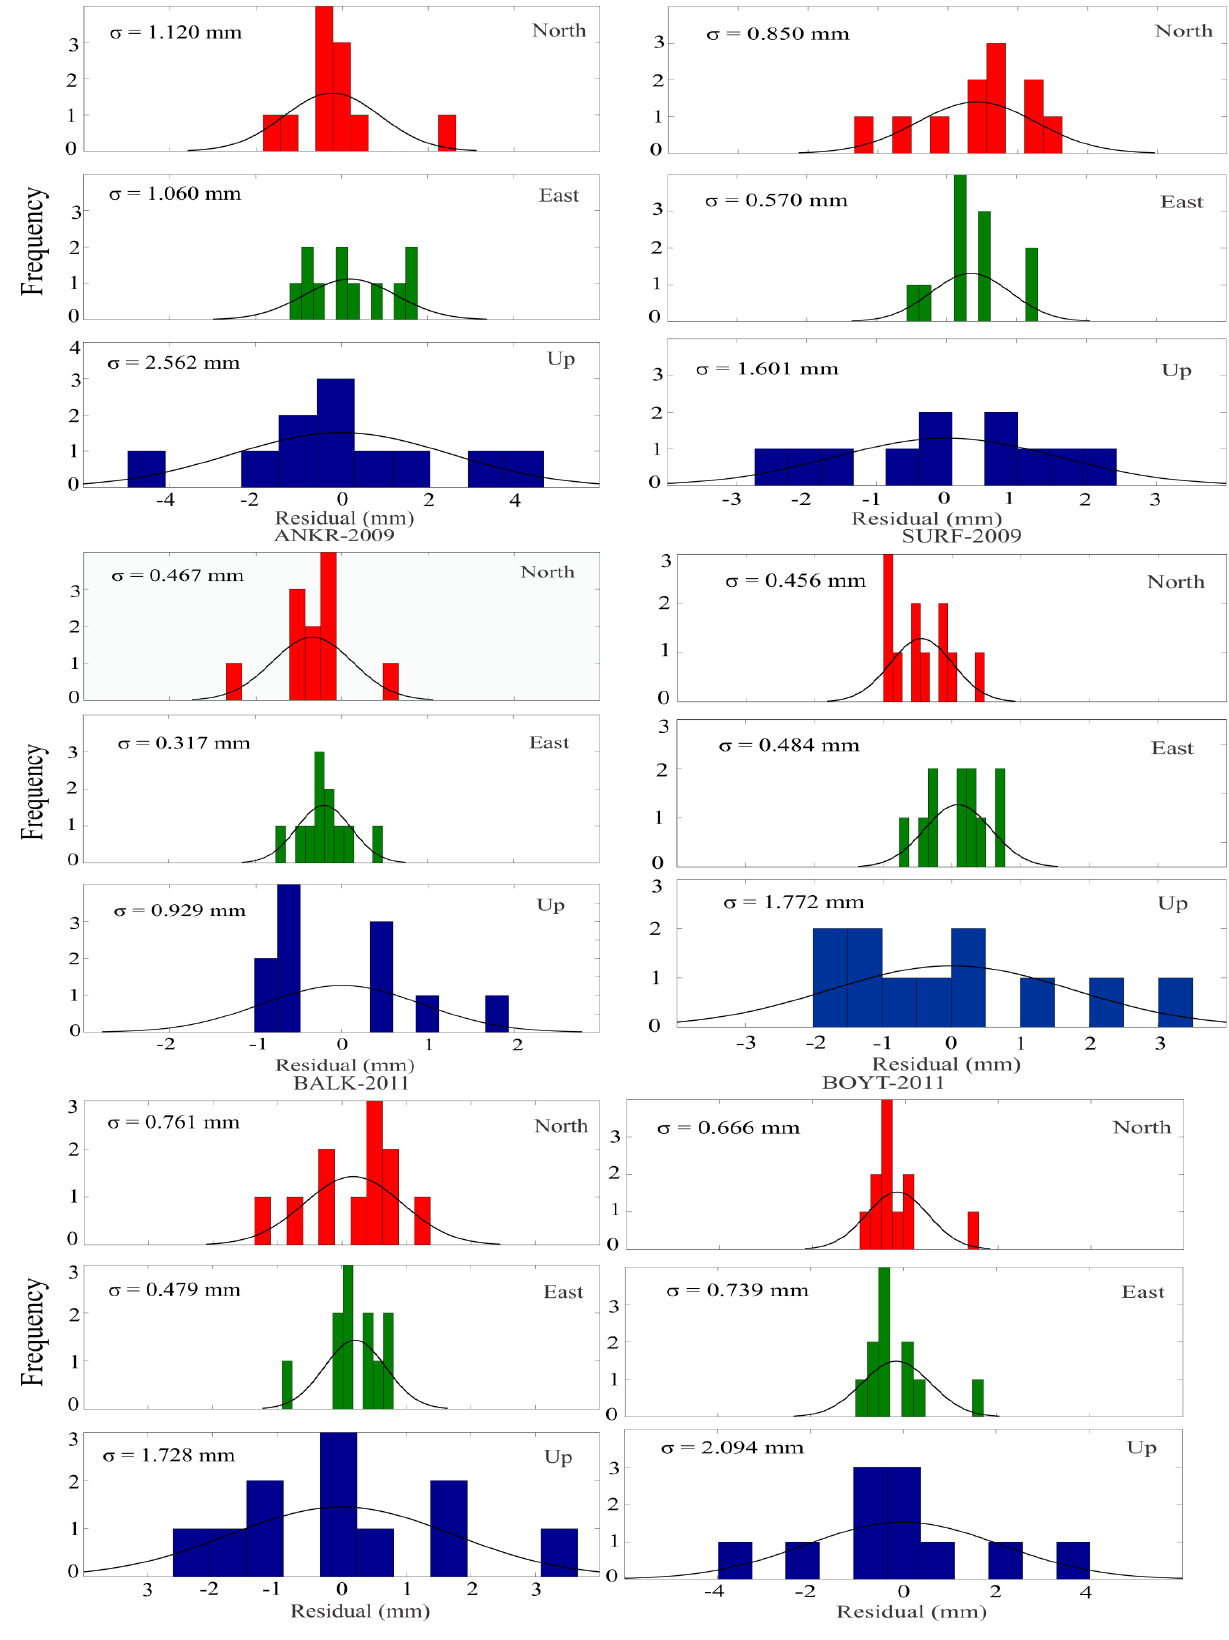
Figure 3: The coordinate reliability of GNSS sites from the year 2009 to